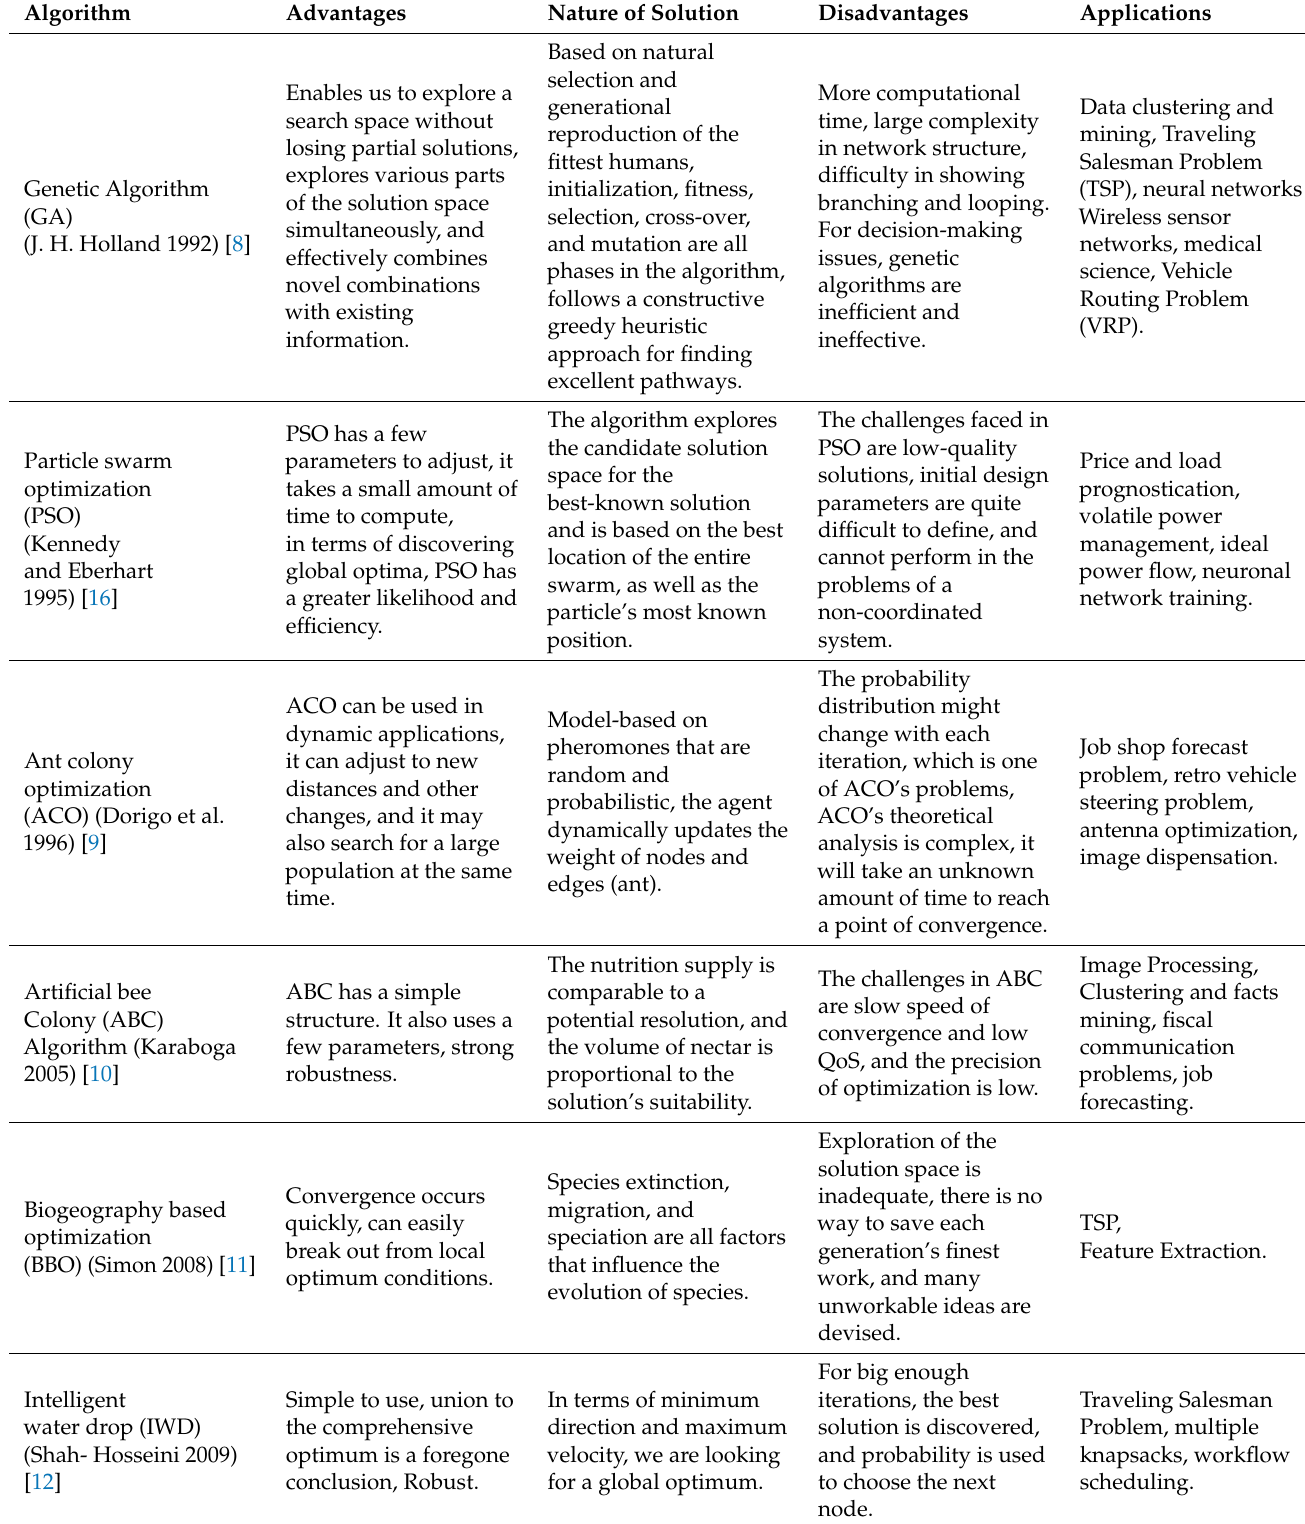
Table 1. A comprehensive comparison of nature-inspired algorithms in